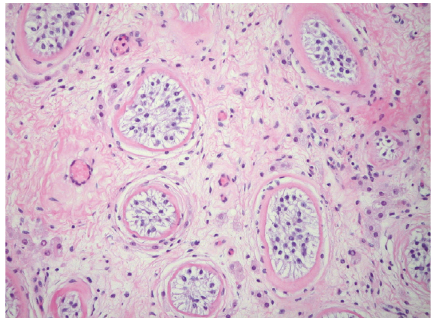
Figure 4: Left testicle, orchiectomy. Atrophic seminiferous tubules with small diameters, absence of spermatogenesis, increased numbers of